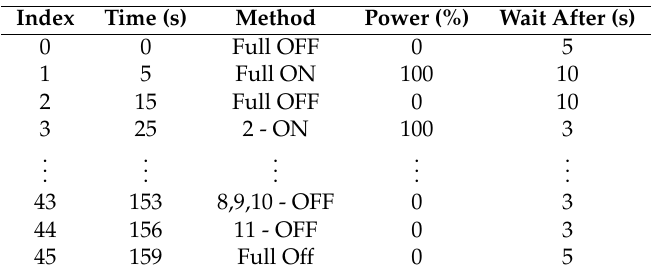
Table 1. Example of formatting a scenario file.